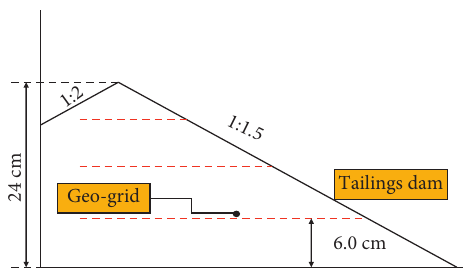
Figure 9: Illustration of geogrid arrangement with 6.0 cm